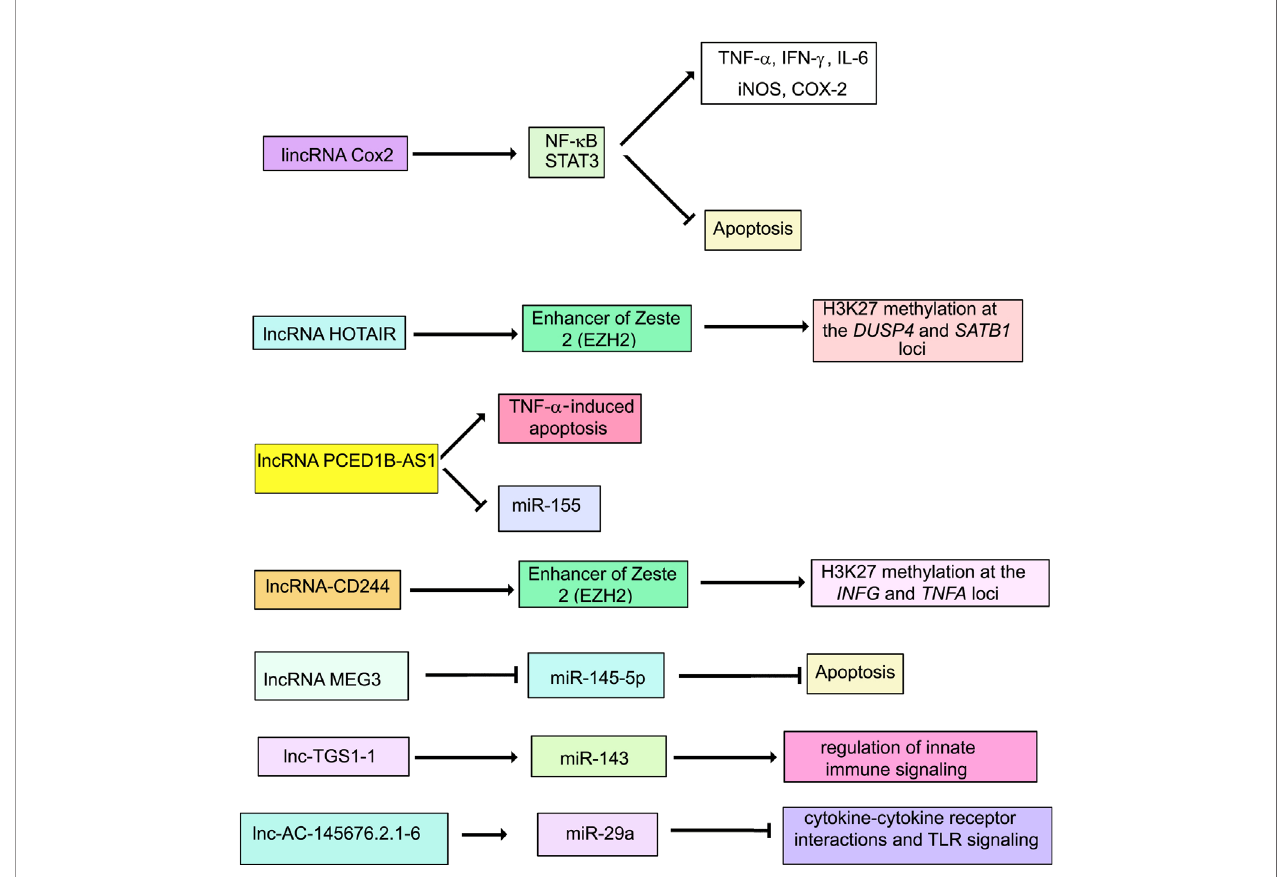
FIGURE 3 | Schematic representation of the role of lncRNAs during M. tuberculosis